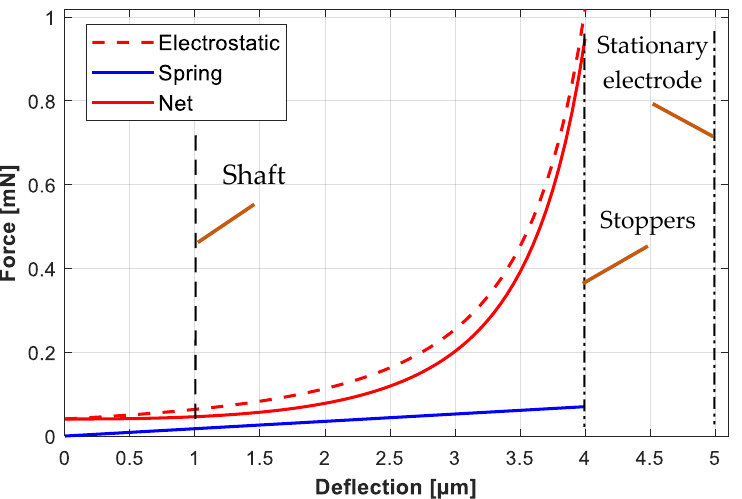
Figure 11. The electrostatic, elastic and net forces developed in an AUC corresponding to the parameters listed in Table 1 when subjected to an actuation voltage amplitude of 100 V.